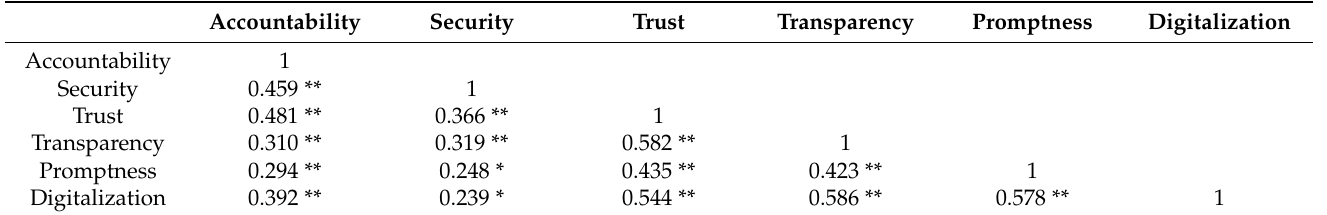
Table 3. Fornell-Larcker Criterion and Correlation.